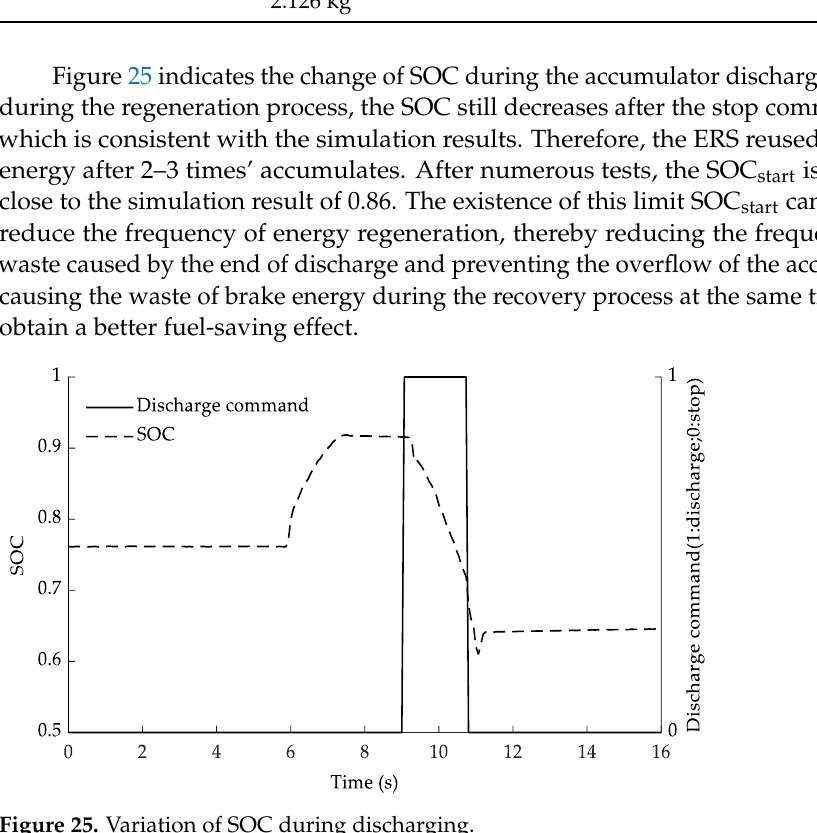
Figure 25. Variation of SOC during discharging.